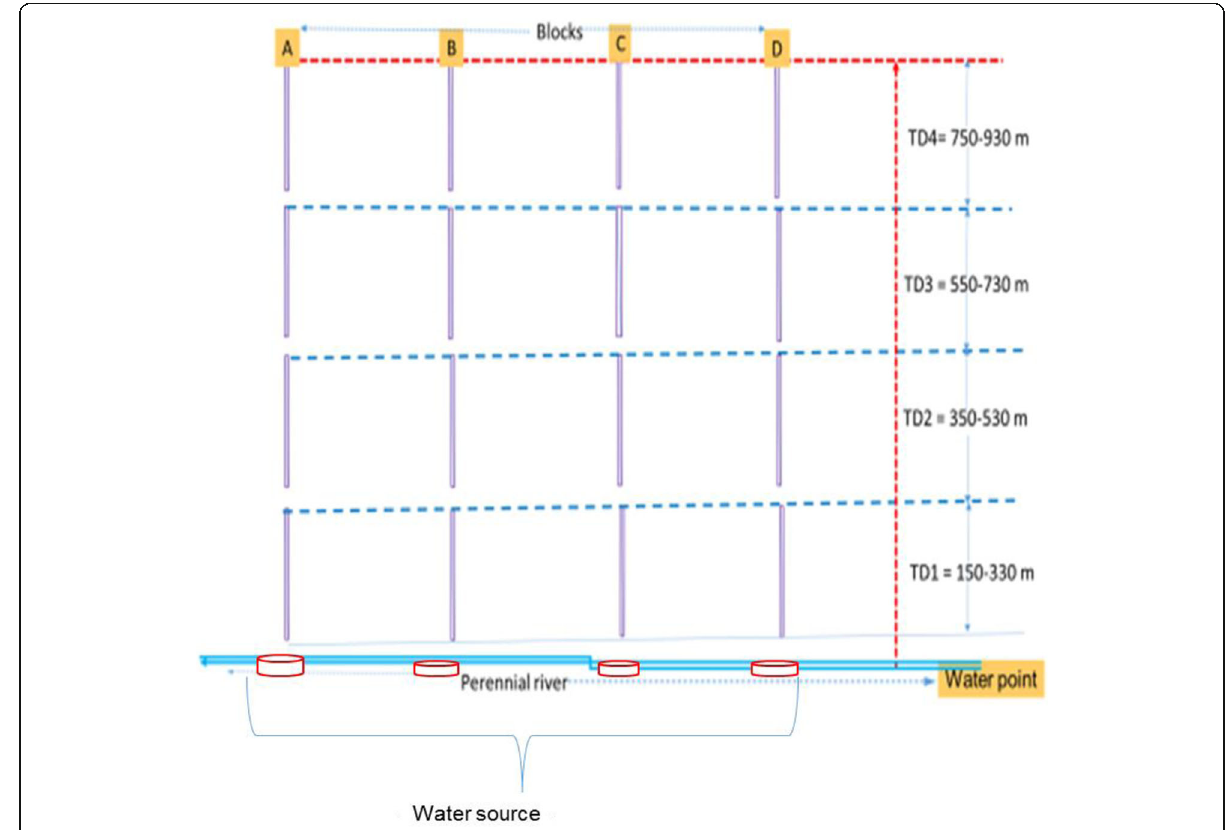
Fig. 2 Schematic representation of the sampling design for transect radiating from water source